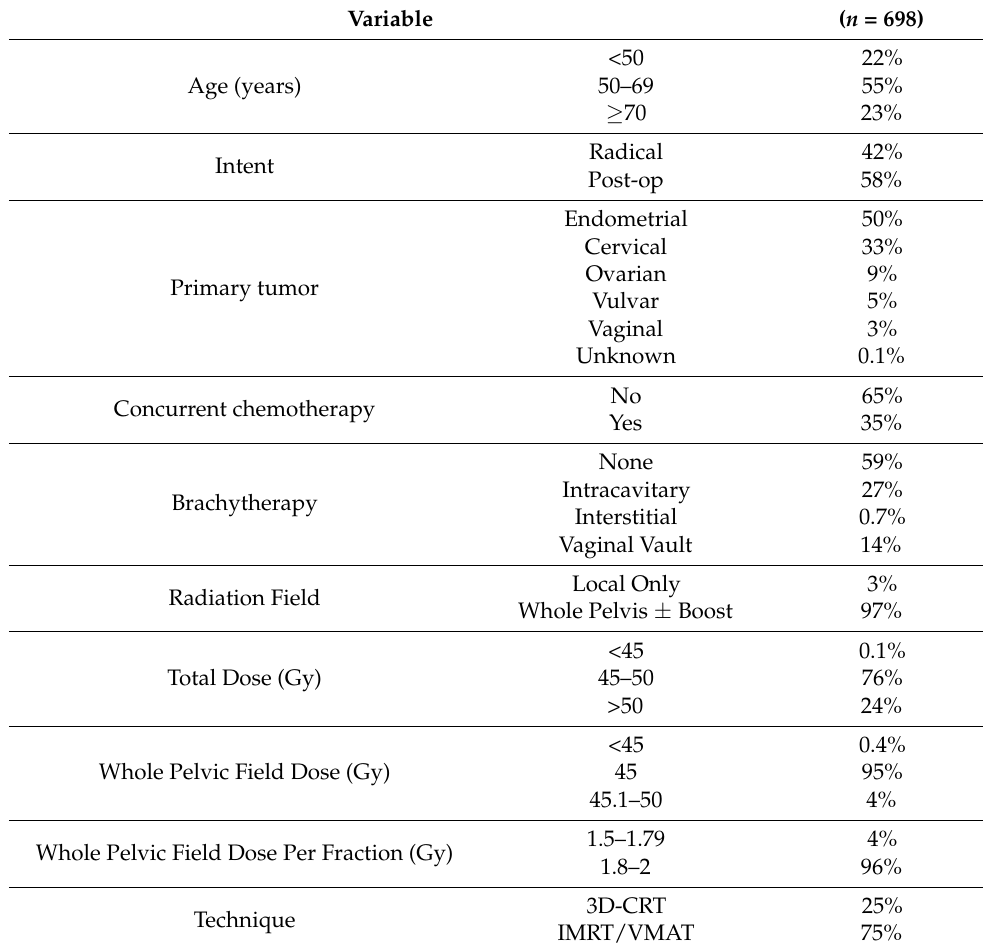
Table 1. Baseline characteristics.